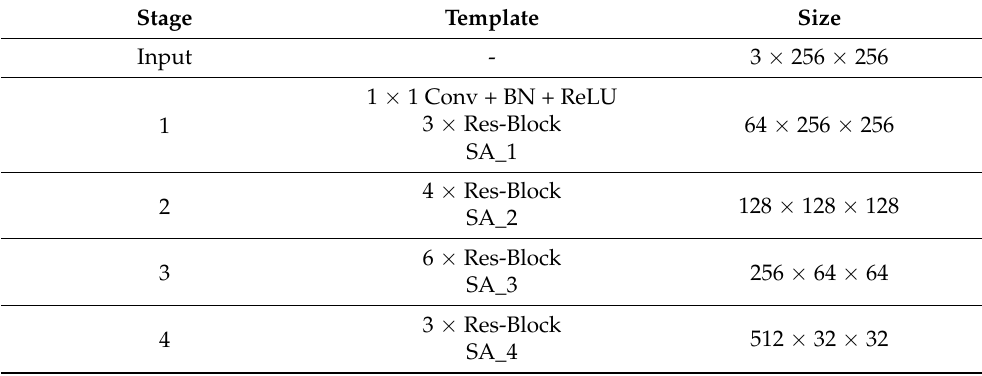
Table 1. The encoder structure and the dimension variation of low level features. SA_1, SA_2, SA_3, and SA_4 denote the SA units of stages 1, 2, 3, and 4, respectively. Here, 3 × 256 × 256 represents the number of channels, height, and width, respectively. In addition, 3 × Res-Block denotes three Res-Blocks. Stage Template Size